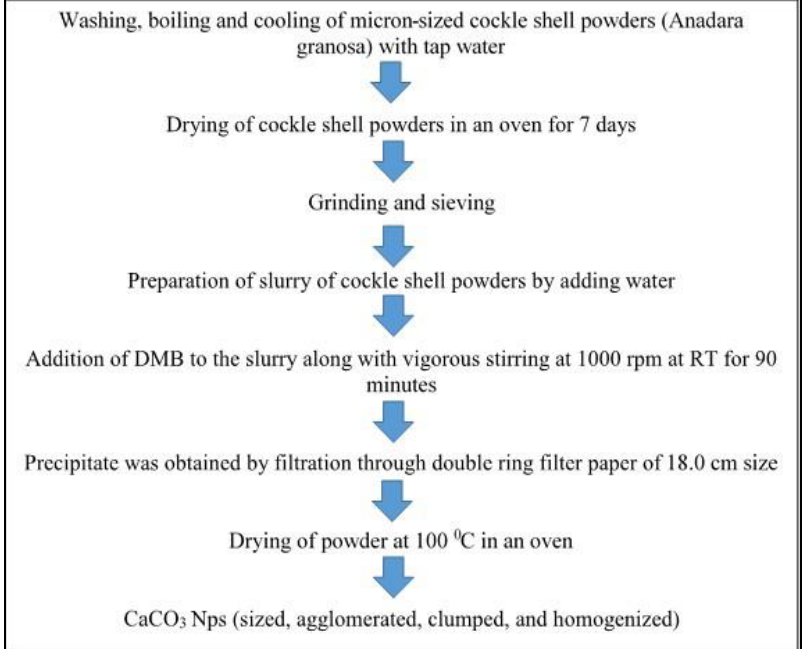
Figure 6. The schematic diagram for the synthesis of calcium carbonate nanoparticles from cockle shells.